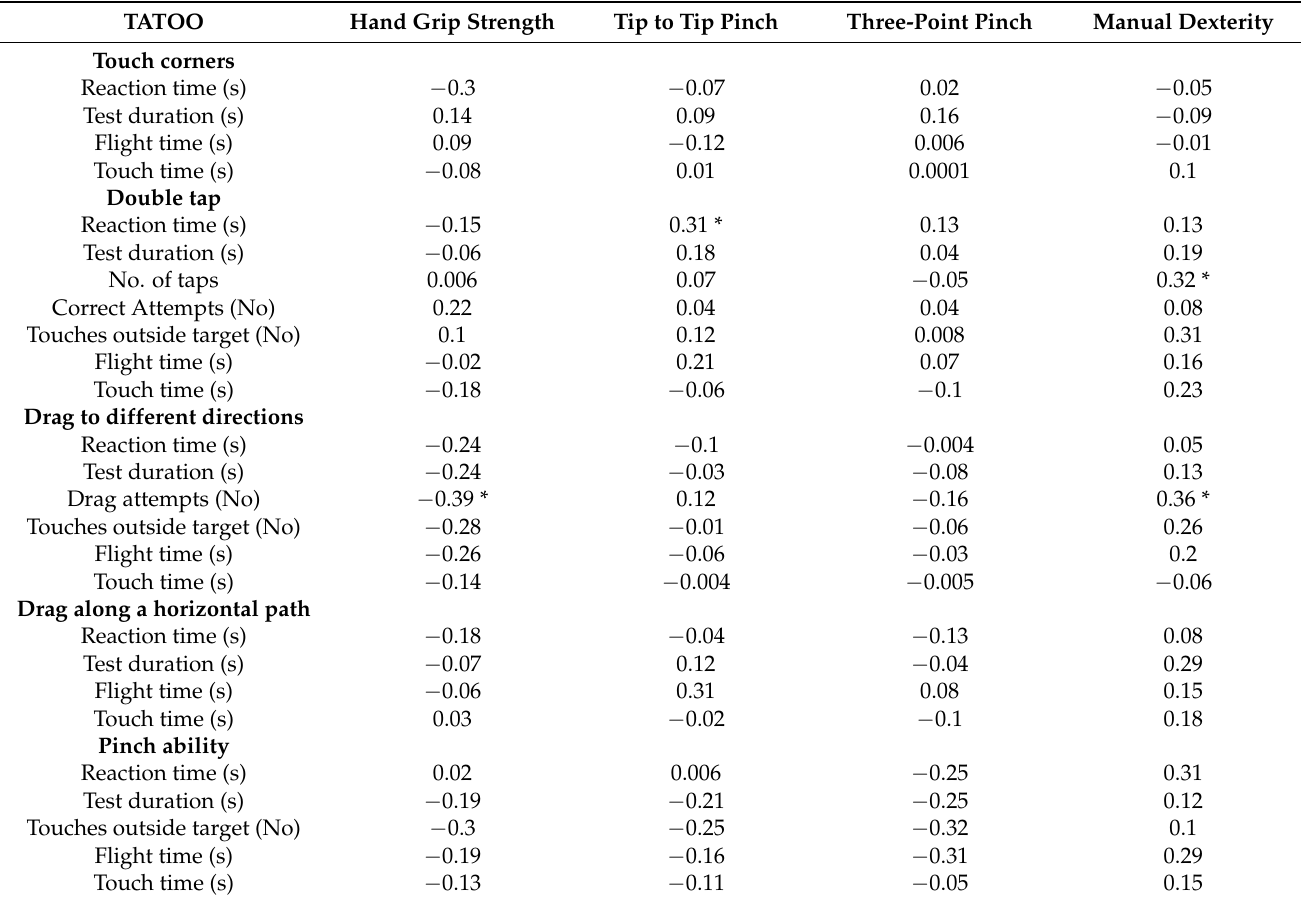
Table 3. Correlation between the TATOO parameters and the traditional hand assessment of the right hand for older individuals (Spearman’s correlation coefficients, * p -value ≤